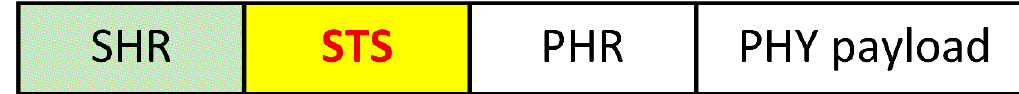
Figure 3. PHY frame format in the 802.15.4z amendment.